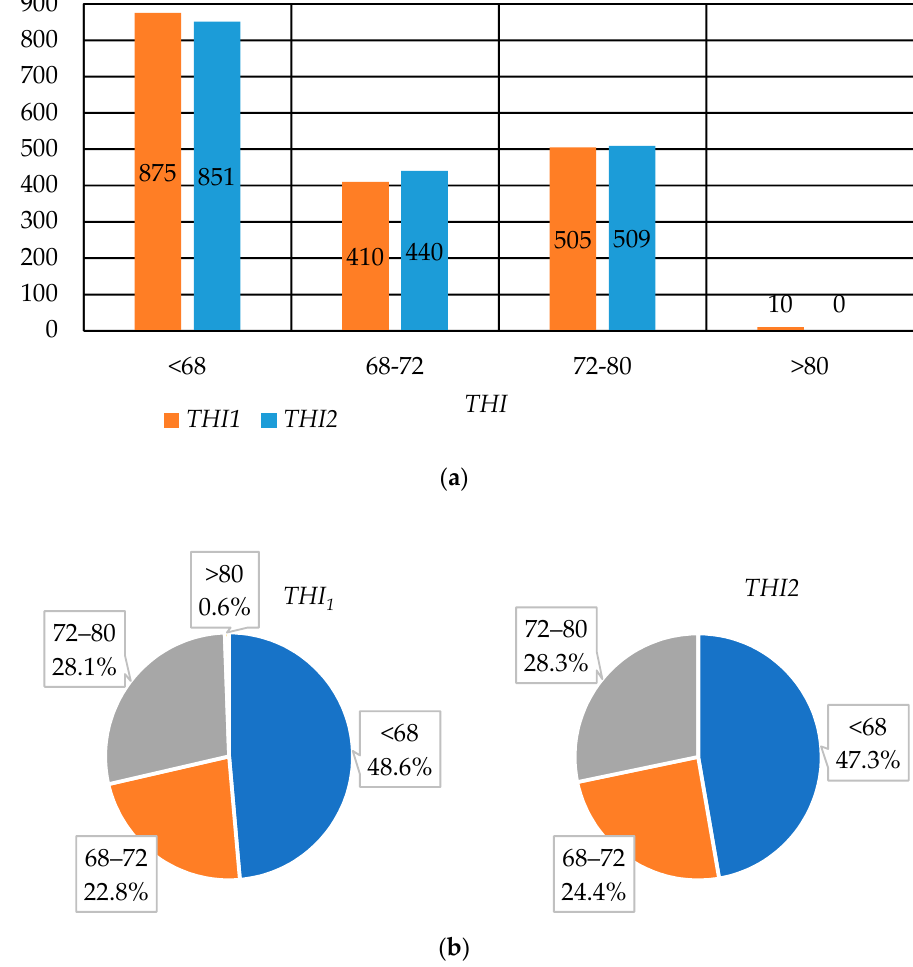
Figure 7. THI distribution by hours ( a ) and by percentage ( b ).